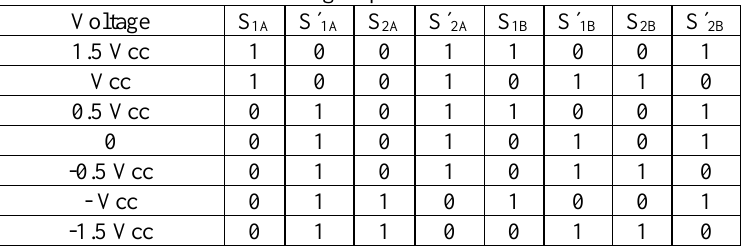
Table 1: Switching sequences for a 7-level